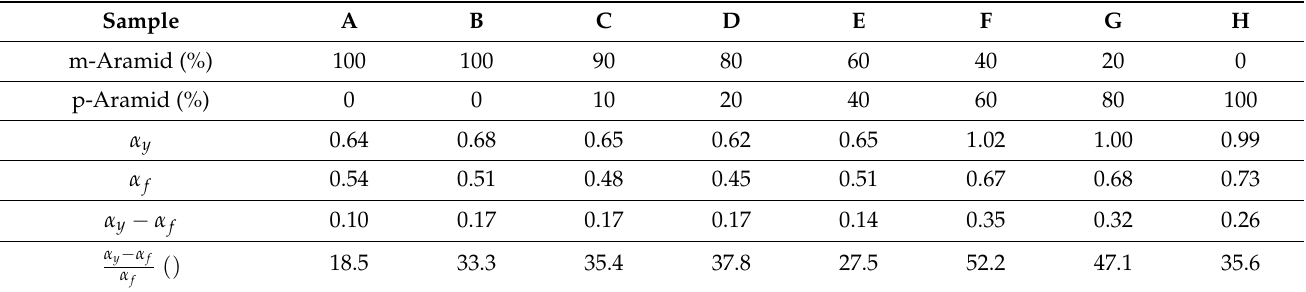
Figure 7. Relationship between degradation coefficient of yarn and fabric ( 𝛼 𝑦 and 𝛼 𝑓 ) by the blend of m-Aramid/p-Aramid based on Equation (3).